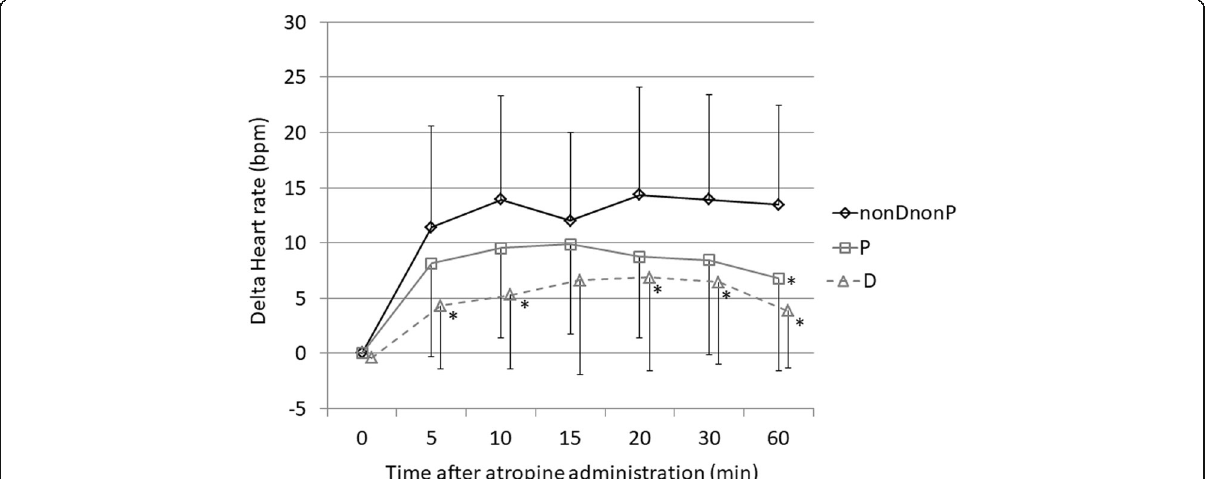
Fig. 2 Increase in heart rate after administration of atropine in the dexmedetomidine, propofol, and non-dexmedetomidine-non-propofol groups. Values are expressed as the mean±SD. * p <0.025 (compared with the nonDnonP group). D, dexmedetomidine; nonDnonP, non dexmedetomidine- non propofol; P, propofol; SD, standard deviation